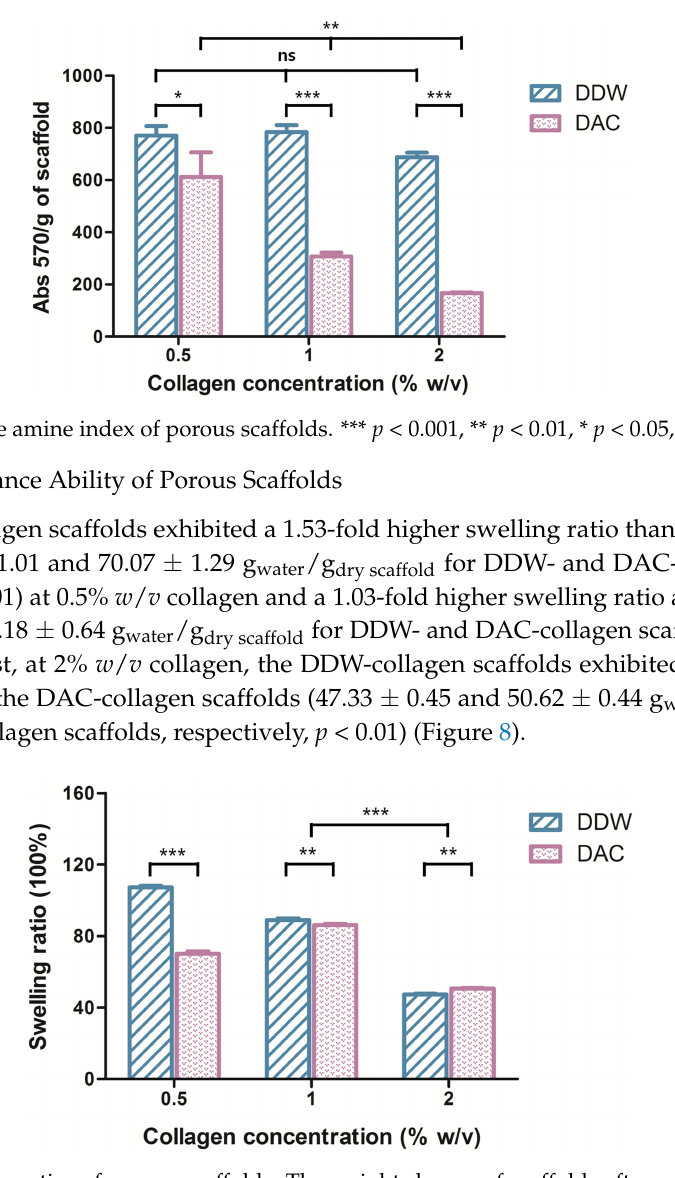
Figure 8. Swelling ratios of porous scaffolds. The weight change of scaffolds after water absorption was measured. *** p < 0.001, ** p <